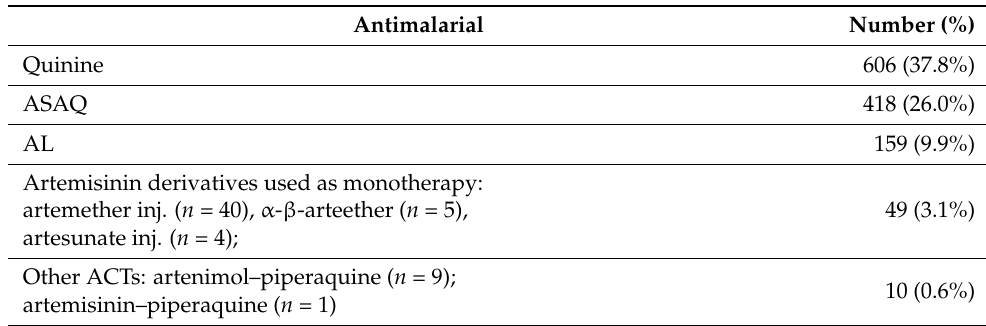
Table 2. Drugs used by the responders ( N =